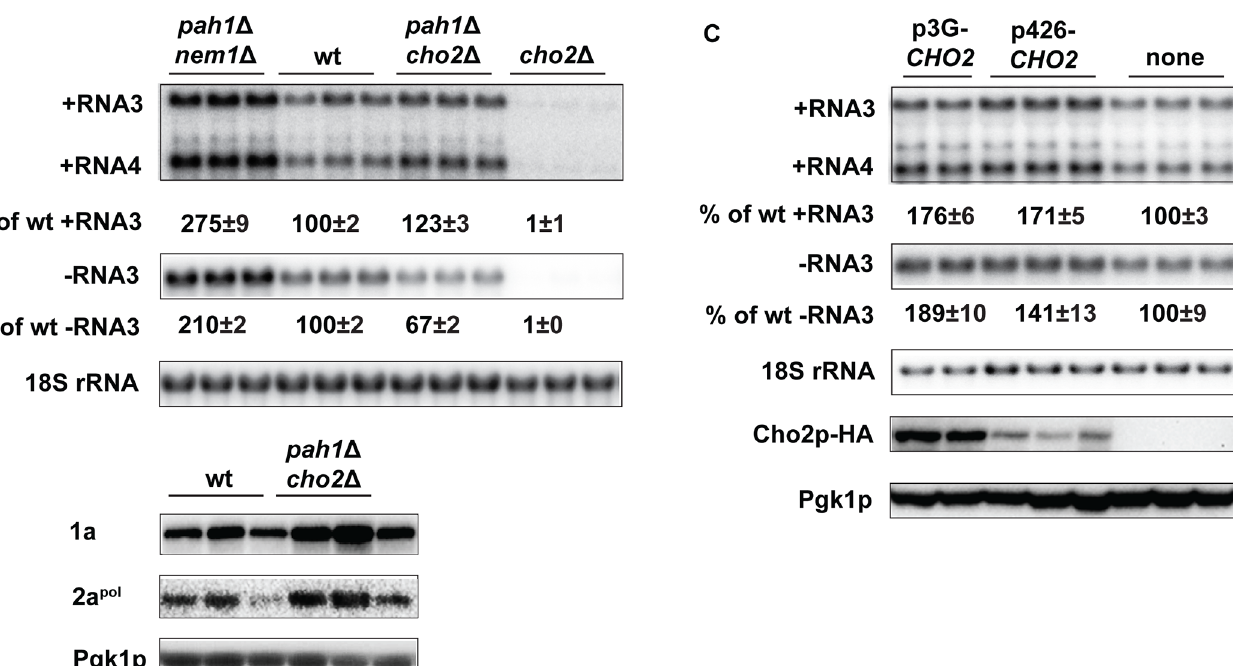
PLOS Pathogens| https://doi.org/10.1371/journal.ppat.1006988 April 12,